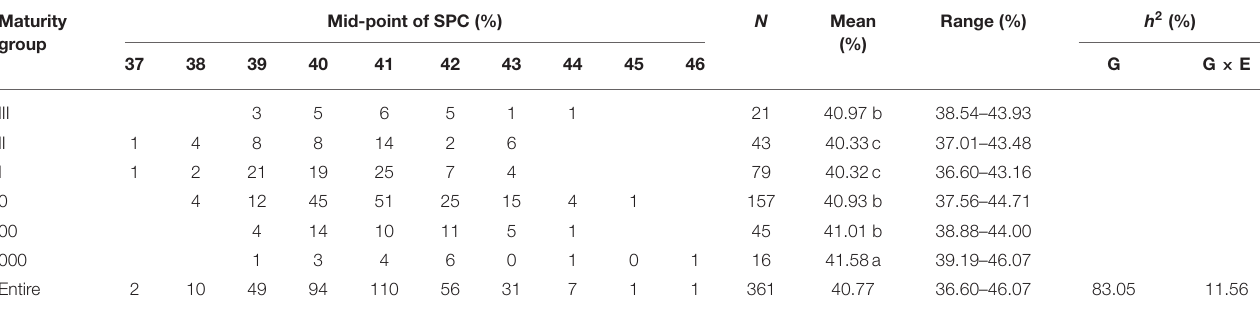
Mid-point of SPC